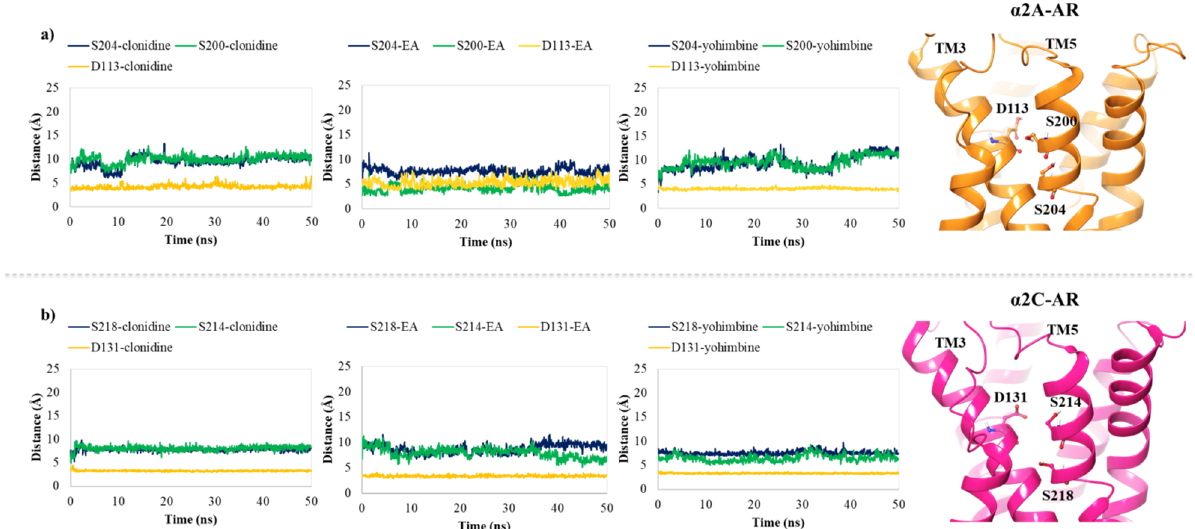
Figure 7. Plots of the distances between the centroid atom of EA, clonidine and yohimbine and ( a ) D113 (orange), S200 (green) and S204 (blue) into the α 2A -AR structure; ( b ) D131 (orange), S214 (green), and S218 (blue) into the α 2C -AR structure, throughout 50 ns of MDs. Right-hand images show zoomed-in context of the pivotal residues, depicted in orange and magenta carbon ball and sticks, involved in the α 2A -AR and α 2C -AR binding pockets, respectively.